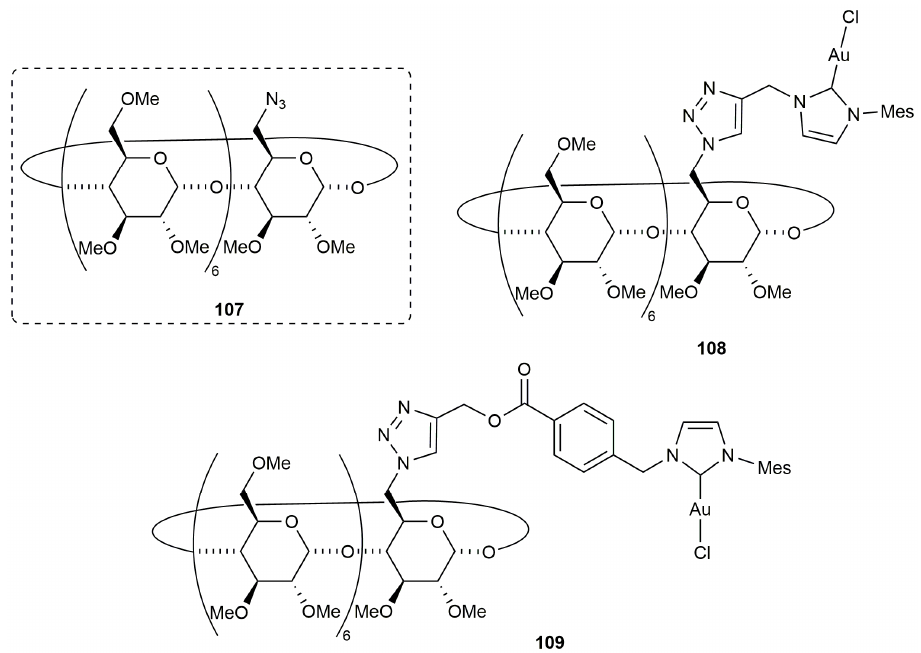
Figure 7. Structure of azide 107 and the cyclodextrin-tagged NHC-Au(I) complexes 108 and 109 .